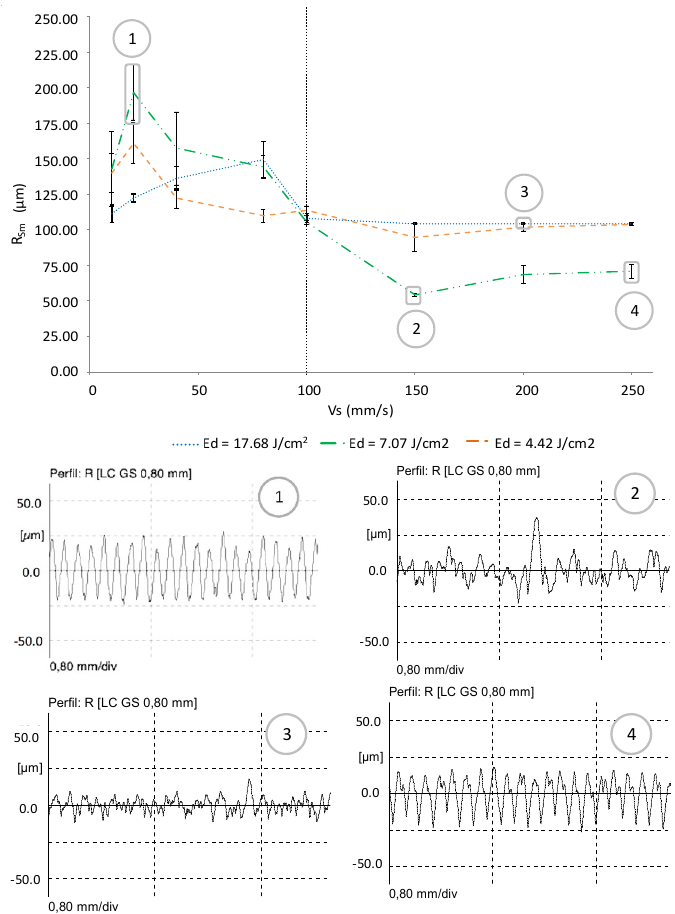
Figure 2. Roughness R Sm behavior as a function of V s .